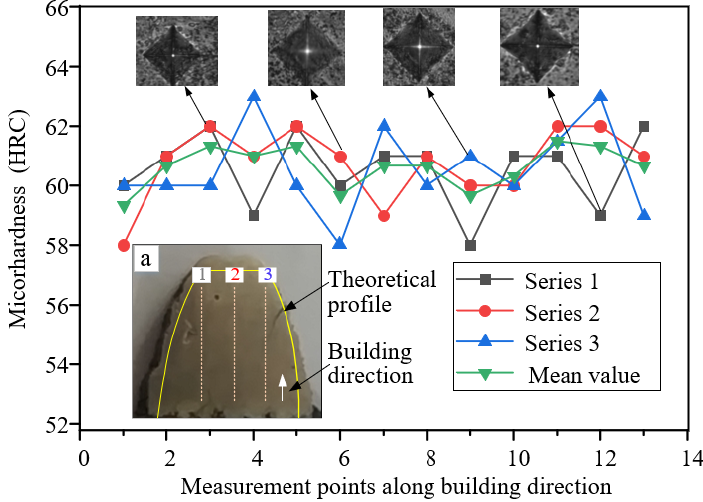
Figure 16. Microhardness and indentation morphologies of the gear teeth.